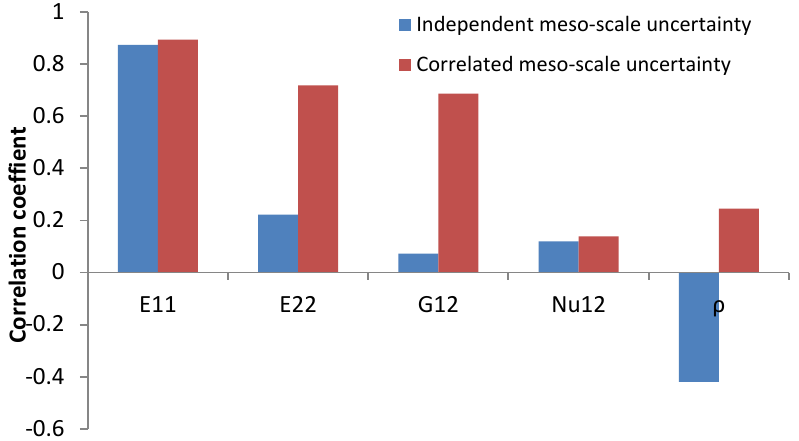
Figure 4. Linear correlation coefficient between first order natural frequency of laminate plate and meso-scale random variables.